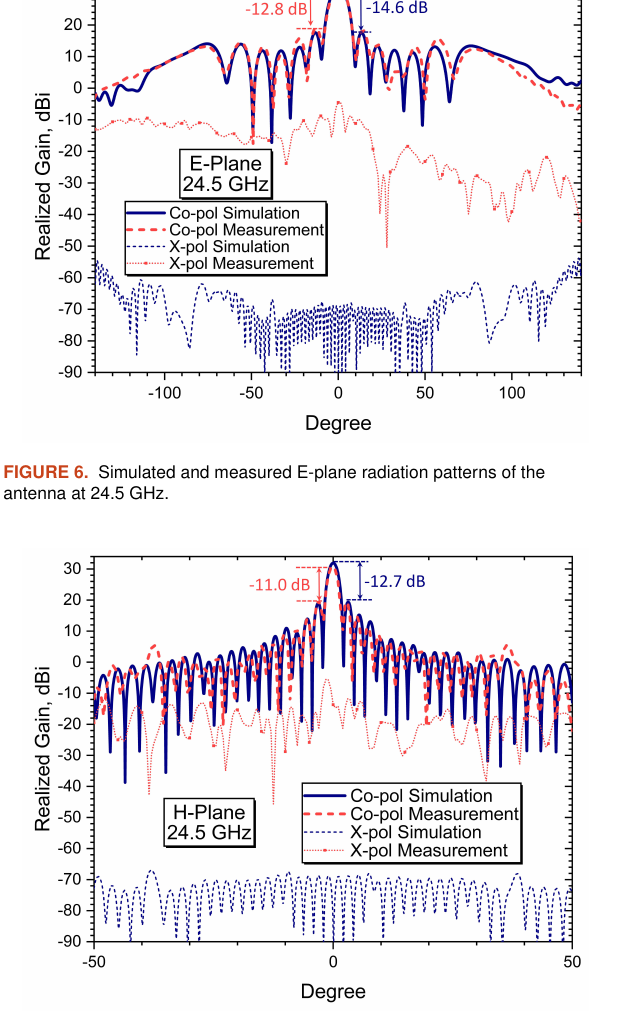
TABLE I. Comparison of the simulation and measurement of the proposed antenna for 24.5 GHz.